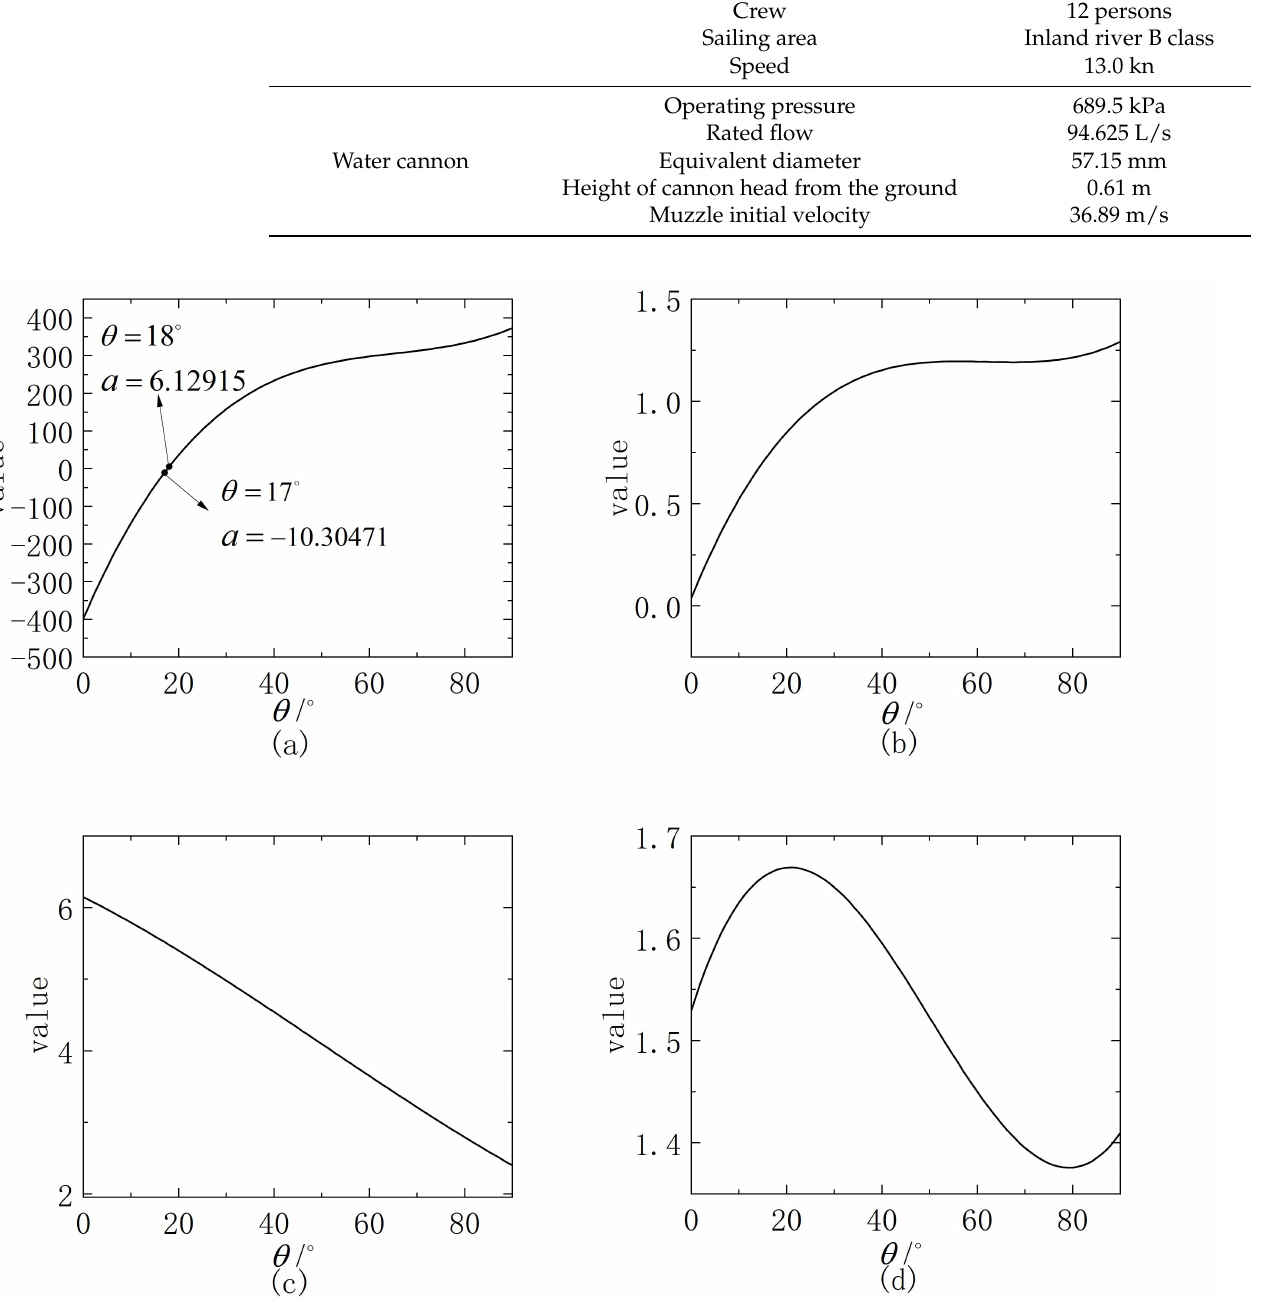
Figure 4. Jet trajectory prediction model coefficients: ( a ) coefficient of variation of the cross-sectional area of the rising section; ( b ) coefficient of variation of the cross-sectional area of the falling section; ( c ) angular acceleration correction factor in the ascent section; ( d ) angular acceleration correction factor in the rise